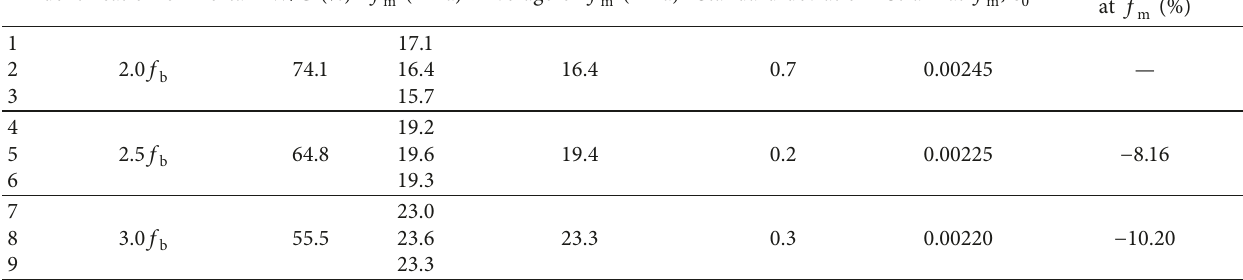
Table 2: Compressive strength of mortars (MPa).